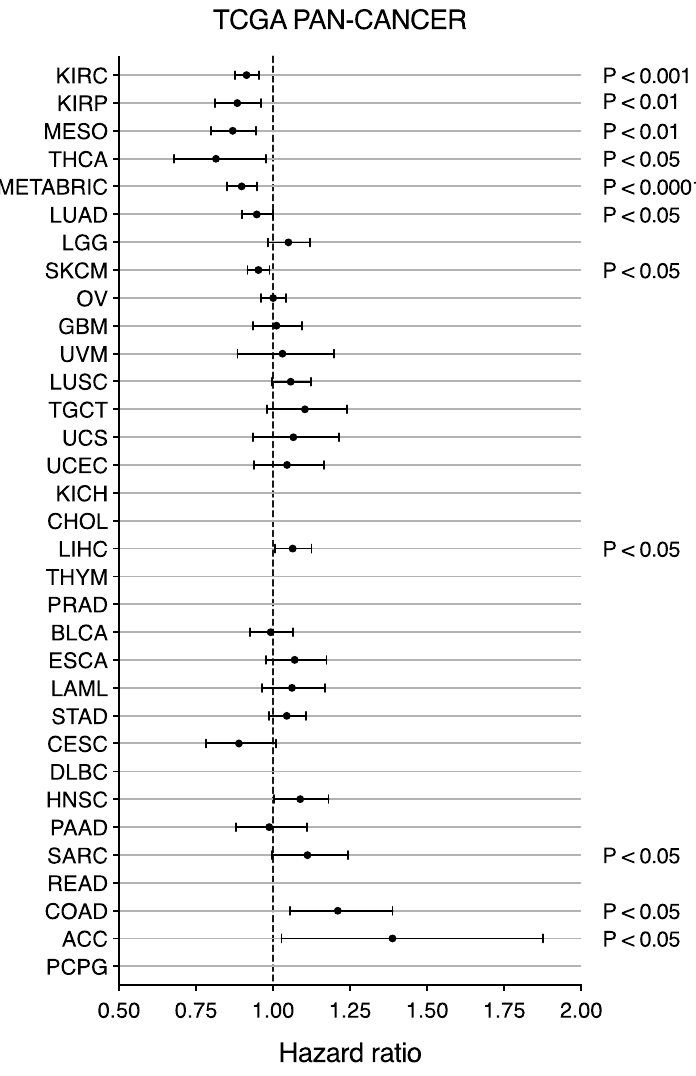
Figure 4. Low LRP2 expression is associated with poor survival in multiple cancers. LRP2 expression hazard ratio with 95% confidence intervals is shown for each cancer type. Hazard ratio < 1 indicates decreased risk with higher LRP2 . Hazard ratio > 1 indicates increased risk with higher LRP2 . Cancer types are ranked (top to bottom) according to their median expression of LRP2 . p value from the likelihood-ratio test is shown for significant cancer types. No data are shown for seven cancer types where analysis was not performed due to insufficient event number. Full list of cancer-type abbreviations is provided in Table S1. Source data provided in Table S2.